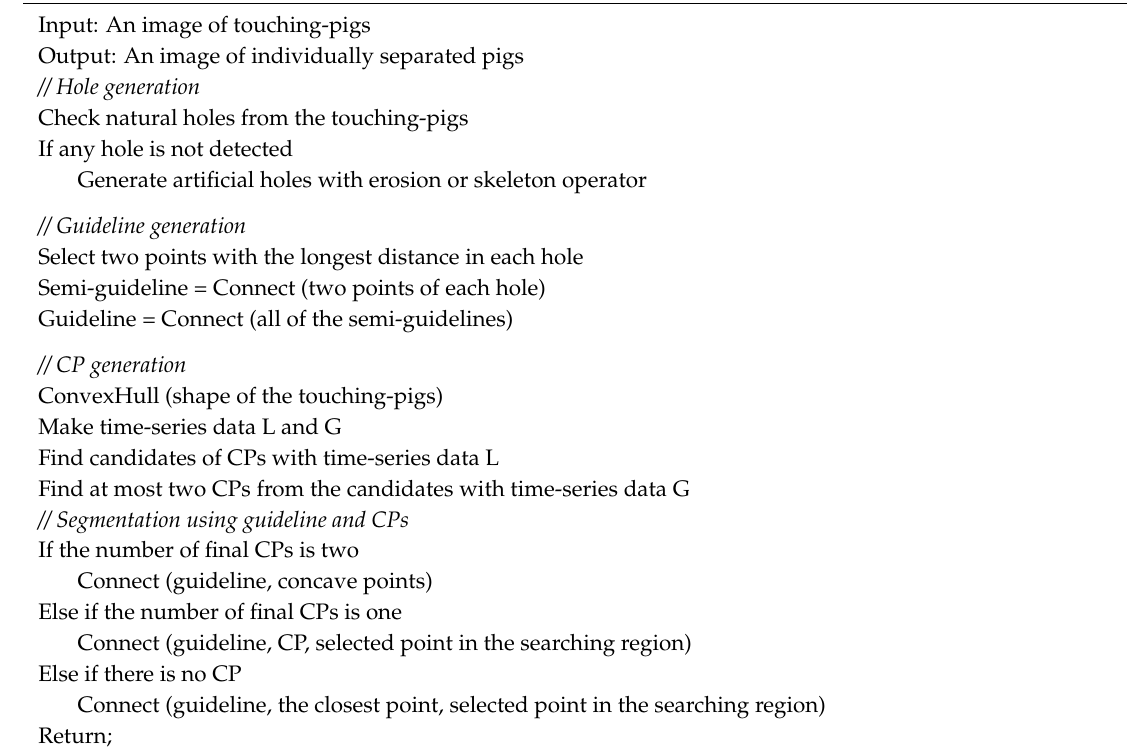
Figure 14. Segmentation with a guideline and CPs: ( a ) Case 1: two CPs; ( b ) Case 2: one CP; ( c ) Case 3: no CP. Algorithm 3 Separation algorithm of Image Processing